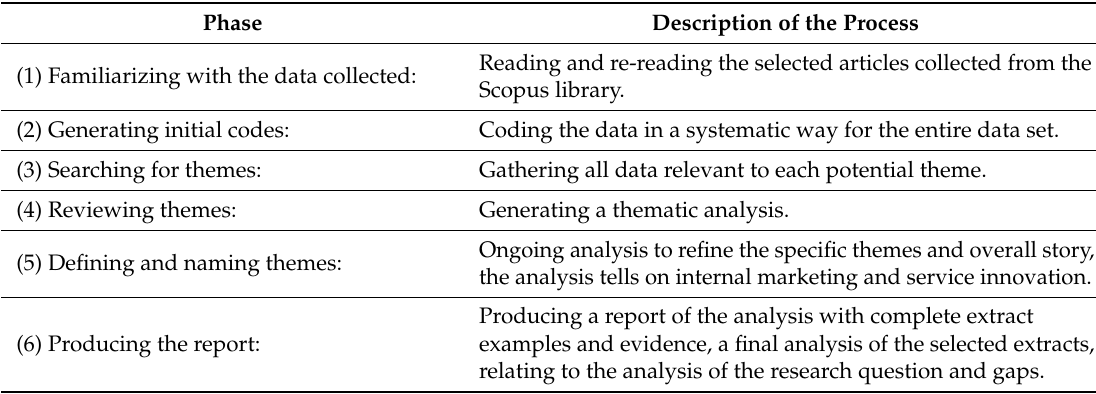
Table 1. Phases of the thematic analysis. Phase Description of the